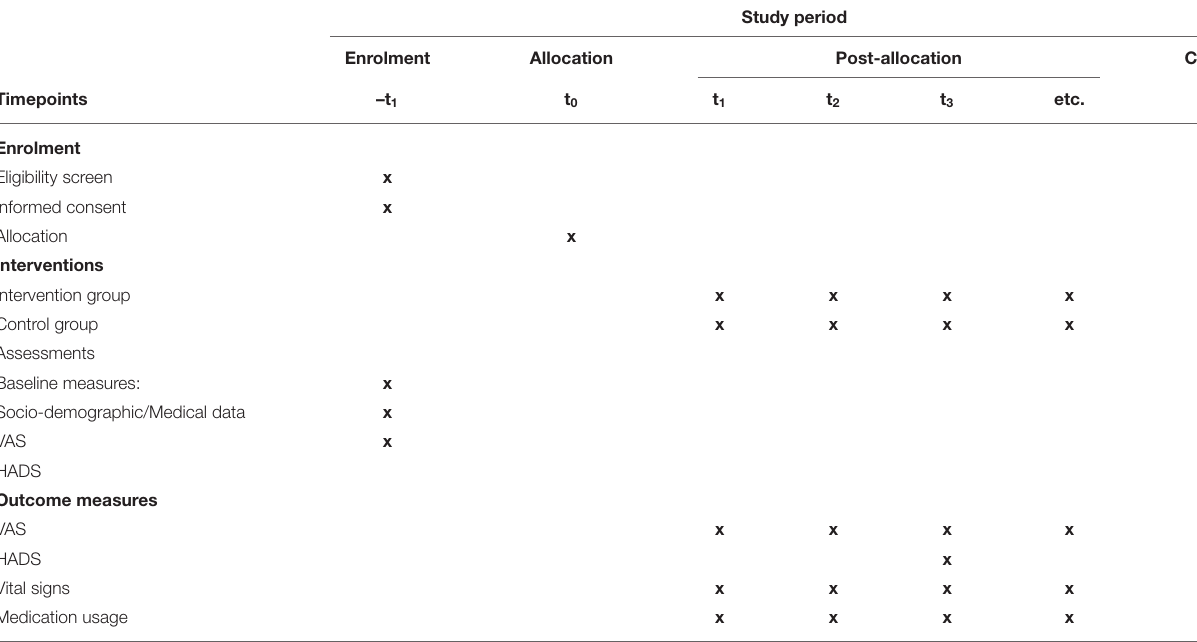
TABLE 1 | Schedule for enrolment, interventions, and